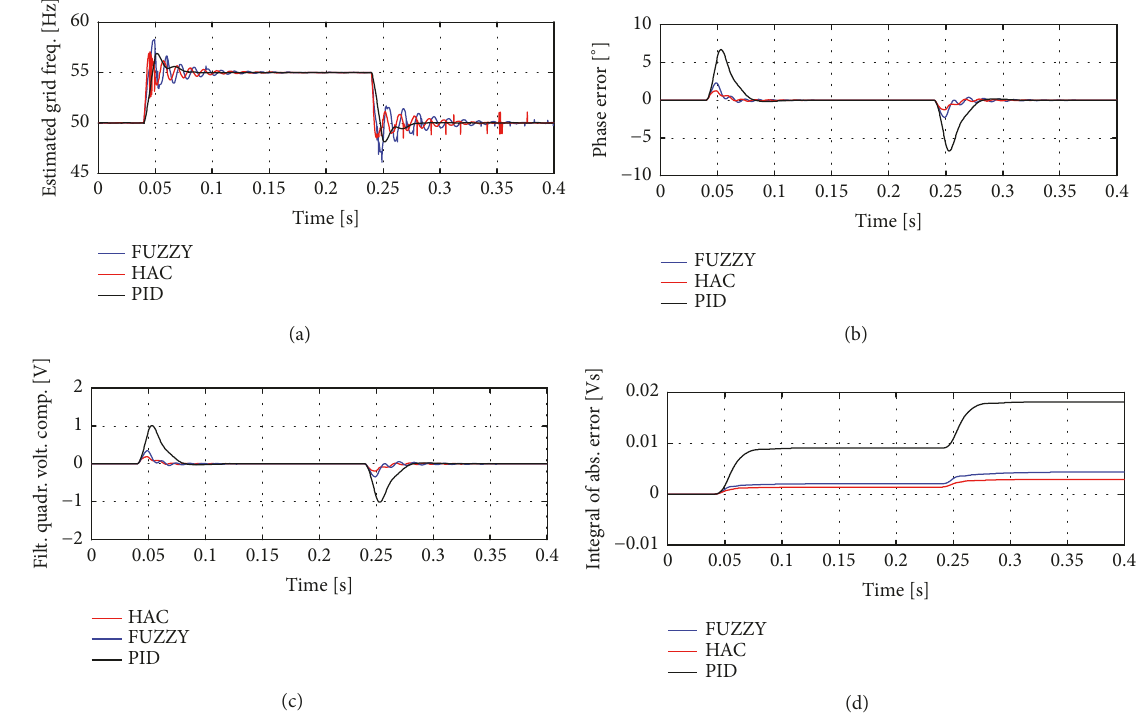
Figure 13: Estimated grid frequency (a), phase error (b), filtered quadrature voltage component 𝑢 𝑞 (c), and integral of absolute error (d) for the step-changes in frequency of ± 5